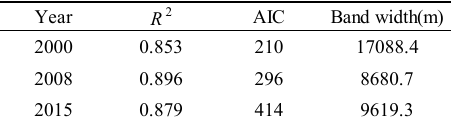
Table 3. Results of GWR